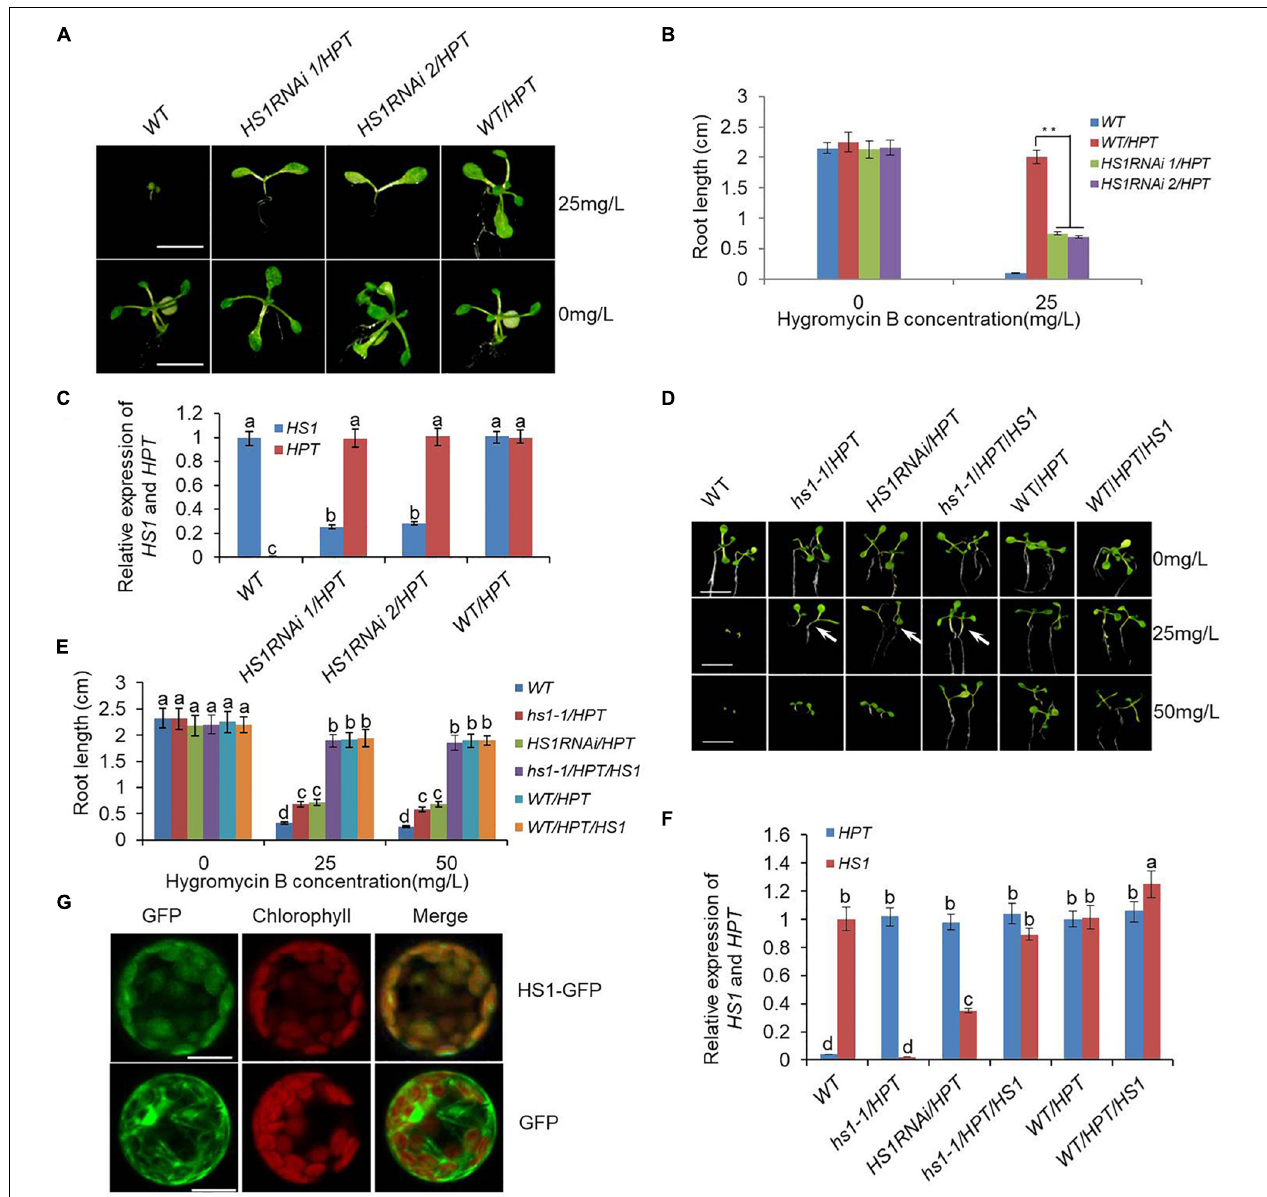
FIGURE 1 | Genetic identification and localization of HS1. (A) Phenotype of HS1 RNAi/ HPT mutants. Ten-day-old seedlings of the wild type (WT), HS1 RNAi/ HPT mutant lines, and empty vector transgenic lines used as the control (WT/ HPT ) were grown on 0.5 × MS medium supplemented with or without HyB as indicated on the right. HS1 RNAi/ HPT mutants show a phenotypic defect characterized by the absence of true leaves and repressed root development in HyB-containing medium. In contrast, HS1 RNAi/ HPT mutant growth was almost normal in medium without HyB. Bars = 3 mm. (B) Root length measurement of 10-day-old seedlings in (A) grown in the presence and absence of HyB-containing medium as indicated. Values are means ± SD of 30–40 seedlings from each transgenic line (** P < 0.01). (C) Quantitative real-time PCR analysis of HS1 and HPT using ACTIN as a reference. T2 generation 10-day-old seedlings and original HS1 RNAi/ HPT lines screened from the hpRNA mutant library were used for analysis. Data represent mean ± SD of three replications. (D) HS1 constitutive expression rescues the phenotypic defect of HS1 mutants grown in HyB-containing medium. Seeds of plants indicated on the top of each panel were germinated on 0.5 × MS medium without or with different concentrations of HyB as indicated on the right and grown for 10 days. hs1-1 / HPT shows the same phenotypic defect as HS1 RNAi mutants ( HS1 RNAi/ HPT ) in plates containing 25 mg/L HyB, while hs1-1 / HPT complementary transgenic plants ( hs1-1 / HPT / HS1 ), transgenic control (WT/ HPT ), and overexpression plants (WT/ HPT / HS1 ) grew normally. Bars = 5 mm. (E) Measurement of seedling root length is the same as described in (D) . Values are means ± SD of 40–50 seedlings of representative transgenic lines from three independent experiments. (F) Quantitative PCR analysis of HS1 and HPT using ACTIN as a reference. Analysis of 10-day-old seedlings of re-transformed HS1 hpRNA lines and other plants are as indicated on the x -axis. Data represent mean ± SD of three replications. (G) Subcellular localization of HS1 by GFP fluorescence. HS1-GFP fluorescence shows HS1 is localized in chloroplasts. Green indicates GFP fluorescence, red shows chloroplast autofluorescence, and yellow shows co-localization in the merged images. The constructs used for transformation are indicated at the right: GFP, as non-fusion GFP protein control; HS1-GFP, signal from the HS1-GFP fusion protein. Bar = 10 µ m. For each column in (C) , (E) , and (F) , different letters a , b , c , d indicates significant differences at P <